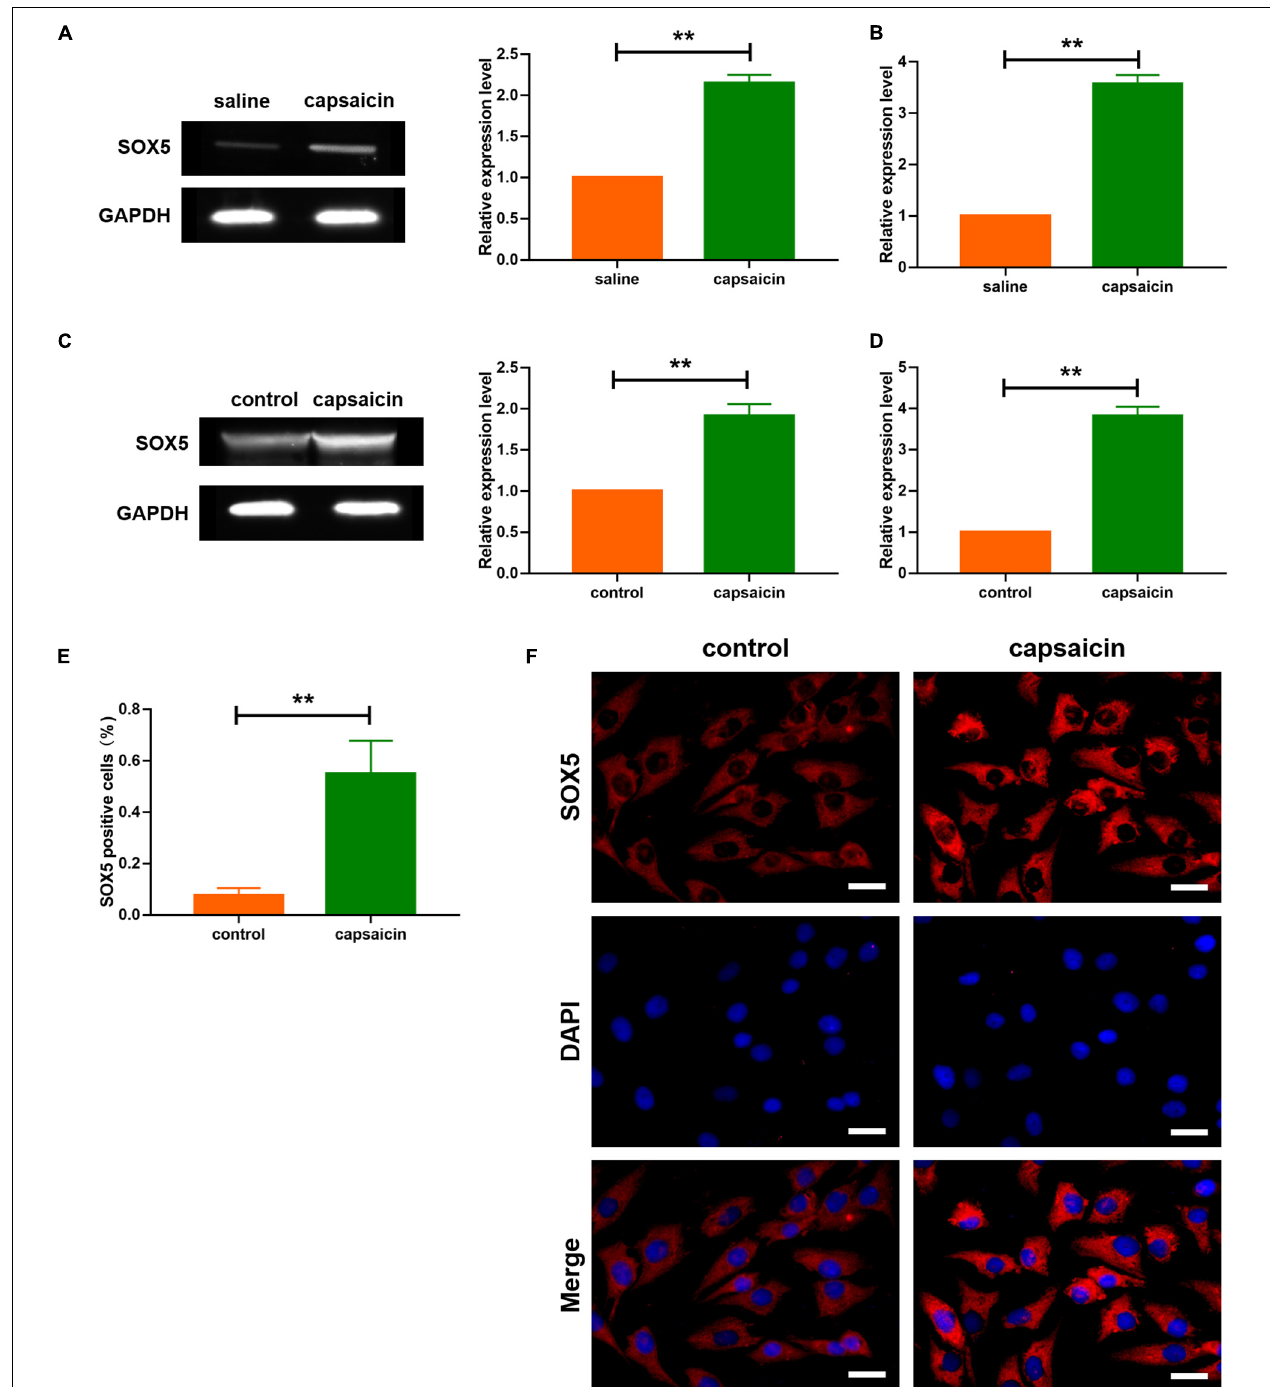
FIGURE 3 | Effect of capsaicin on Sox5 in guinea pig and neuronal cells. (A) Expression level of SOX5 after capsaicin treatment in guinea pigs. Data are mean ± SEM; two-tailed t -test was used for statistical analysis. (B) mRNA expression level of SOX5 in guinea pigs after capsaicin treatment. Data are mean ± SEM; two-tailed t -test was used for statistical analysis. (C) Expression level of SOX5 after capsaicin treatment in neuronal cells. Data are mean ± SEM; two-tailed t -test was used for statistical analysis. (D) mRNA expression level of SOX5 in neuronal cells after capsaicin treatment. Data are mean ± SEM; two-tailed t -test was used for statistical analysis. (E) SOX5 level, as determined using immunofluorescence, and SOX5-positive staining in trachea and lung tissues of guinea pigs. Data are mean ± SEM; two-tailed t -test was used for statistical analysis. (F) Immunostaining analysis showing that capsaicin upregulated the expression of SOX5 in neuronal cells. Scale bars represent 100 µ m. ** P < 0.01; n =